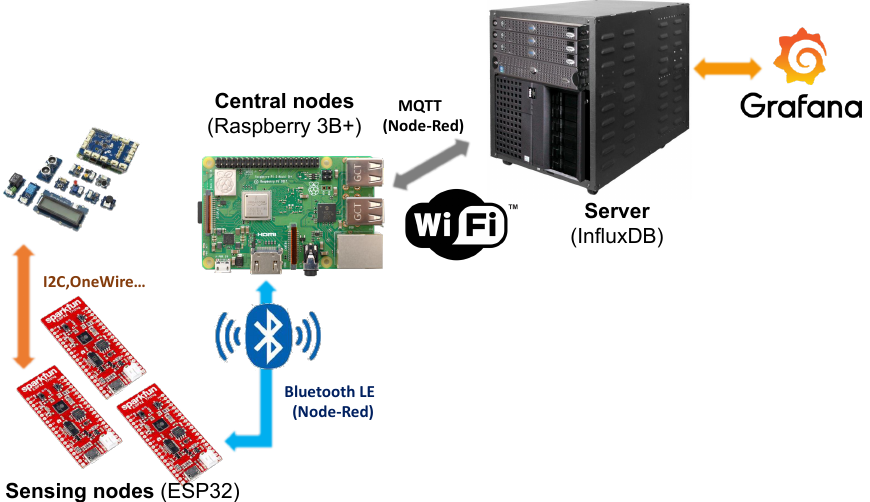
Figure 14. Data path diagram and communication